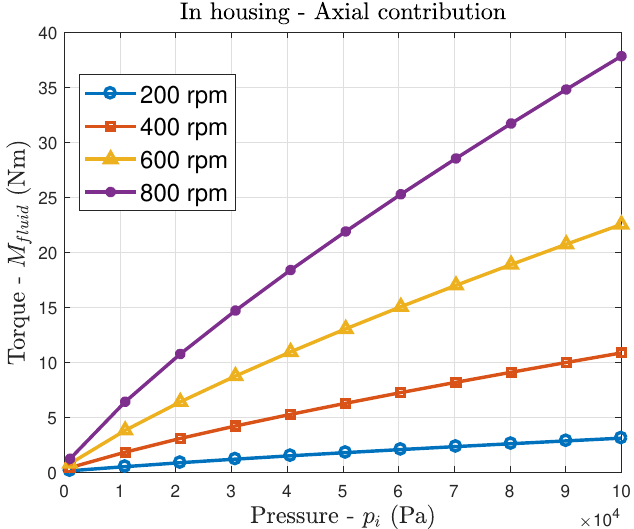
Figure 3. Axial component of the fluid friction torque as a function of the pressure at different rotational velocities.